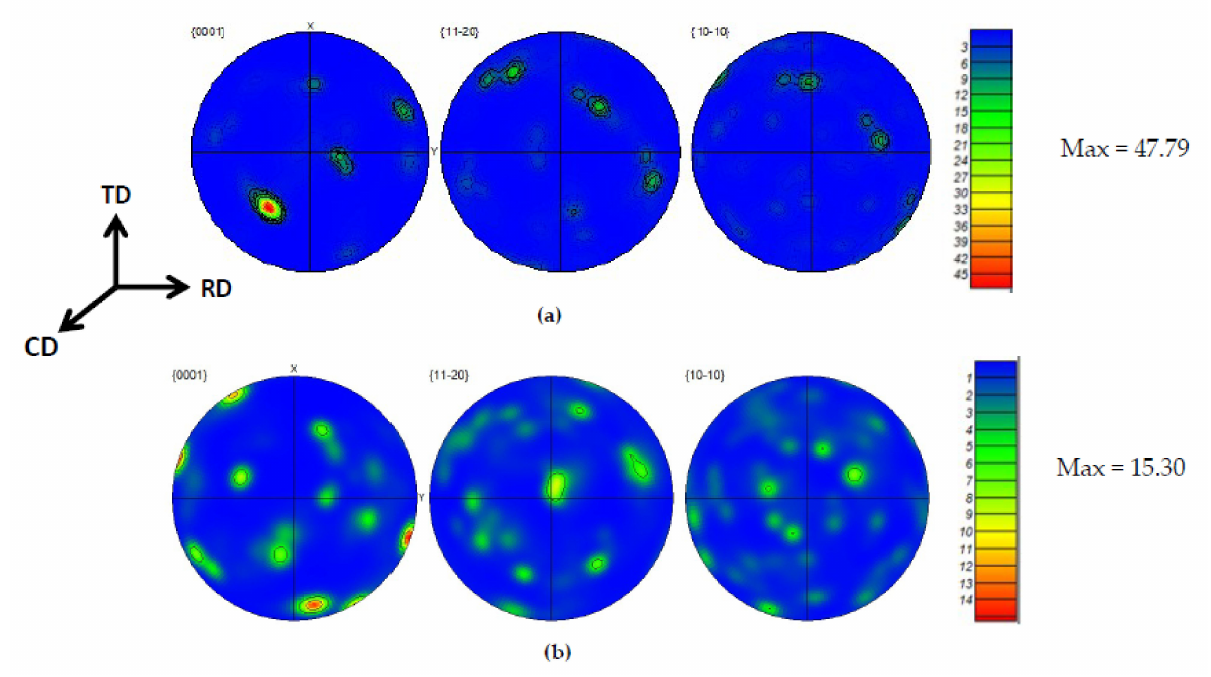
Figure 15. Pole figure map of α phase during deformation at 840 ◦ C at a strain rate of ( a ) 0.01 s − 1 and ( b ) 0.001 s − 1